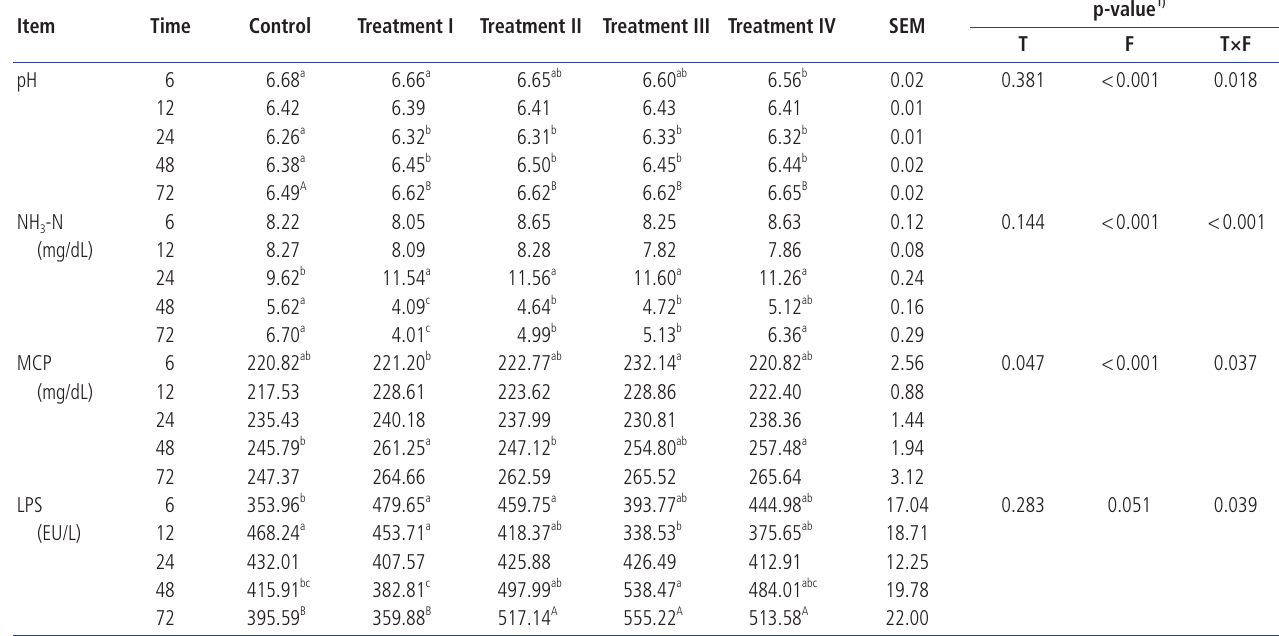
Table 5. Influence of zinc-bearing palygorskite on rumen fermentation parameters Item